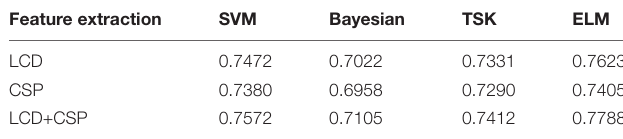
TABLE 5 | Kappa coefficient of data sets